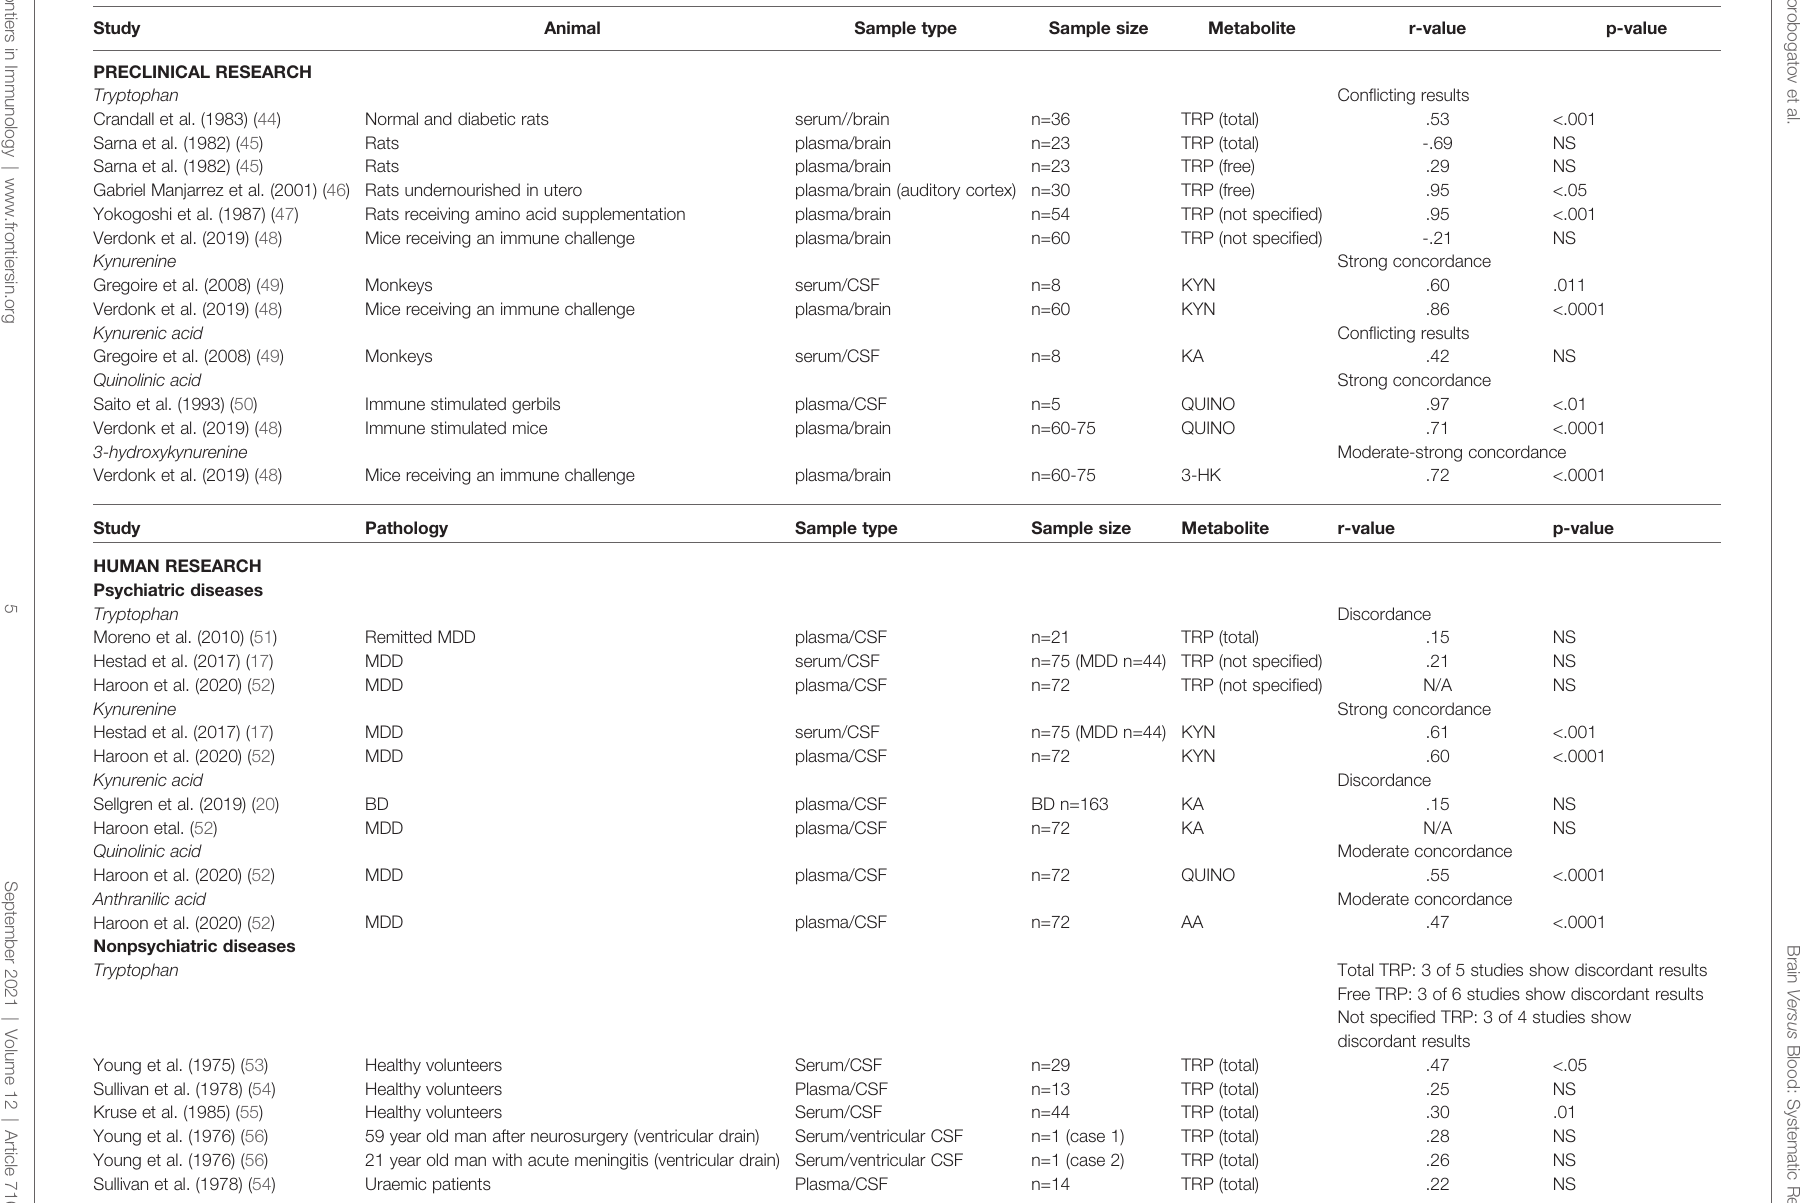
TABLE 1 | Overview of studies investigating correlations between blood-based and CSF kynurenine pathway